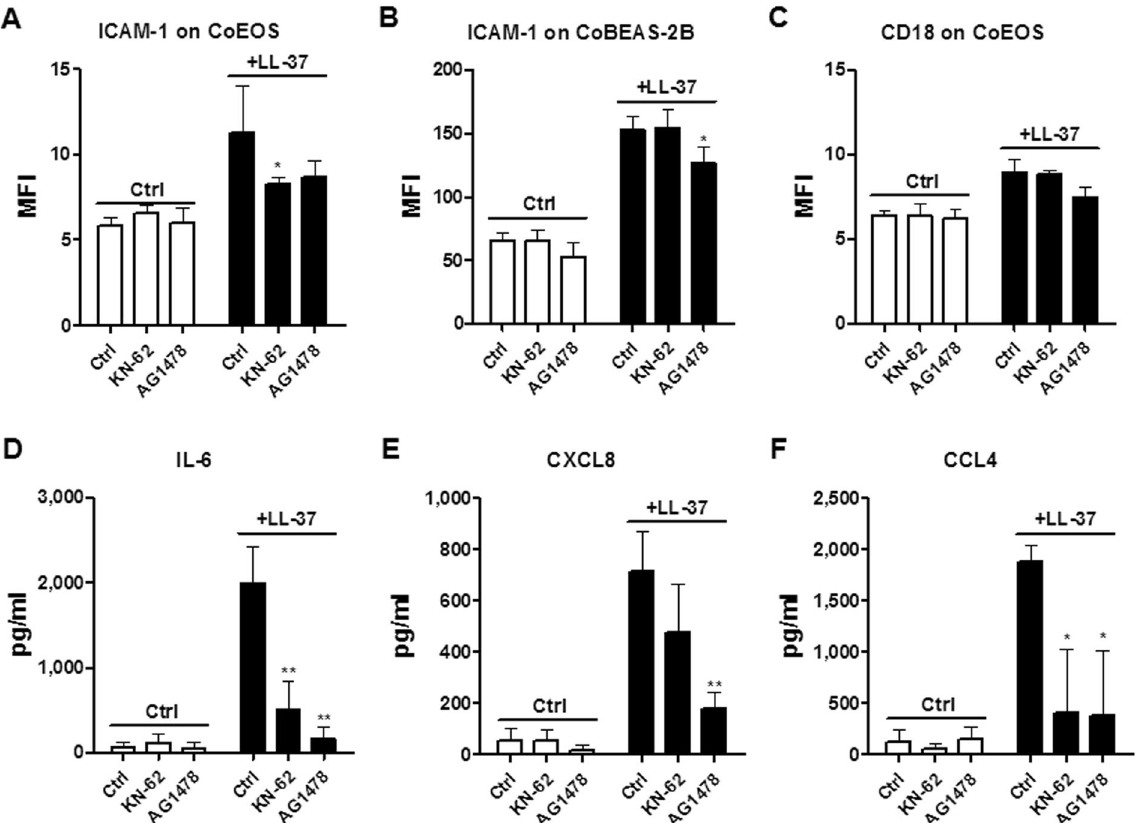
Figure 3. Effects of KN-62 and AG1478 on the expression of adhesion molecules and cytokines/chemokines in co-cultured eosinophils and BEAS-2B cells under LL-37 stimulation. Human eosinophils (3 × 10 5 ) co-cultured with BEAS-2B cells (1 × 10 5 ) were pretreated with KN-62 (5 µ M) and AG1478 (1 µ M) for 1 hour, followed by incubation with 10 µ g/ml LL-37 for further 20 h. ICAM-1 expression on eosinophils ( A ), BEAS-2B cells ( B ), and the CD18 expression on eosinophils ( C ) were analyzed and expressed as previously described. Release of IL-6 ( D ), CXCL8 ( E ) and CCL4 ( F ) in culture supernatant was determined. Results are shown as arithmetic mean plus SD of triplicate independent experiments. * P < 0.05, ** P < 0.01 when compared between the denoted groups and the corresponding control groups with LL-37